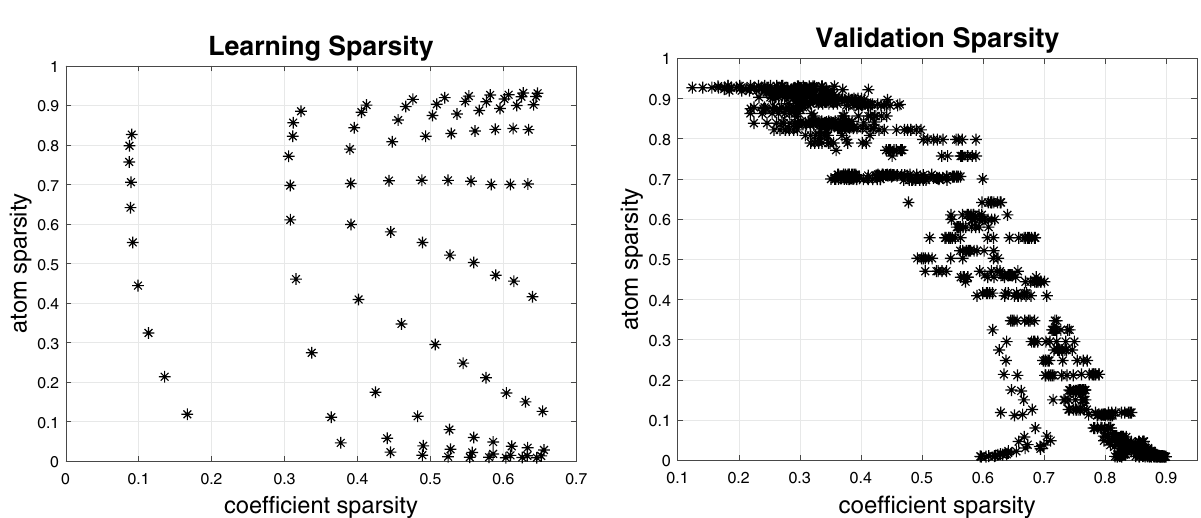
Figure 6. SRSSD method applied to navigation data from animal R01. Left: learning phase. Right: validation phase. Results are shown for dictionaries of size 150 (corresponding to lowest RMS in the test set/validation phase), with 10 values of coefficient sparsity and 5 levels of noise (0.1, 0.3, 0.5, 0.7, 0.9). Notice that the solution space is extensively covered, across both (coefficient and atom sparsity)